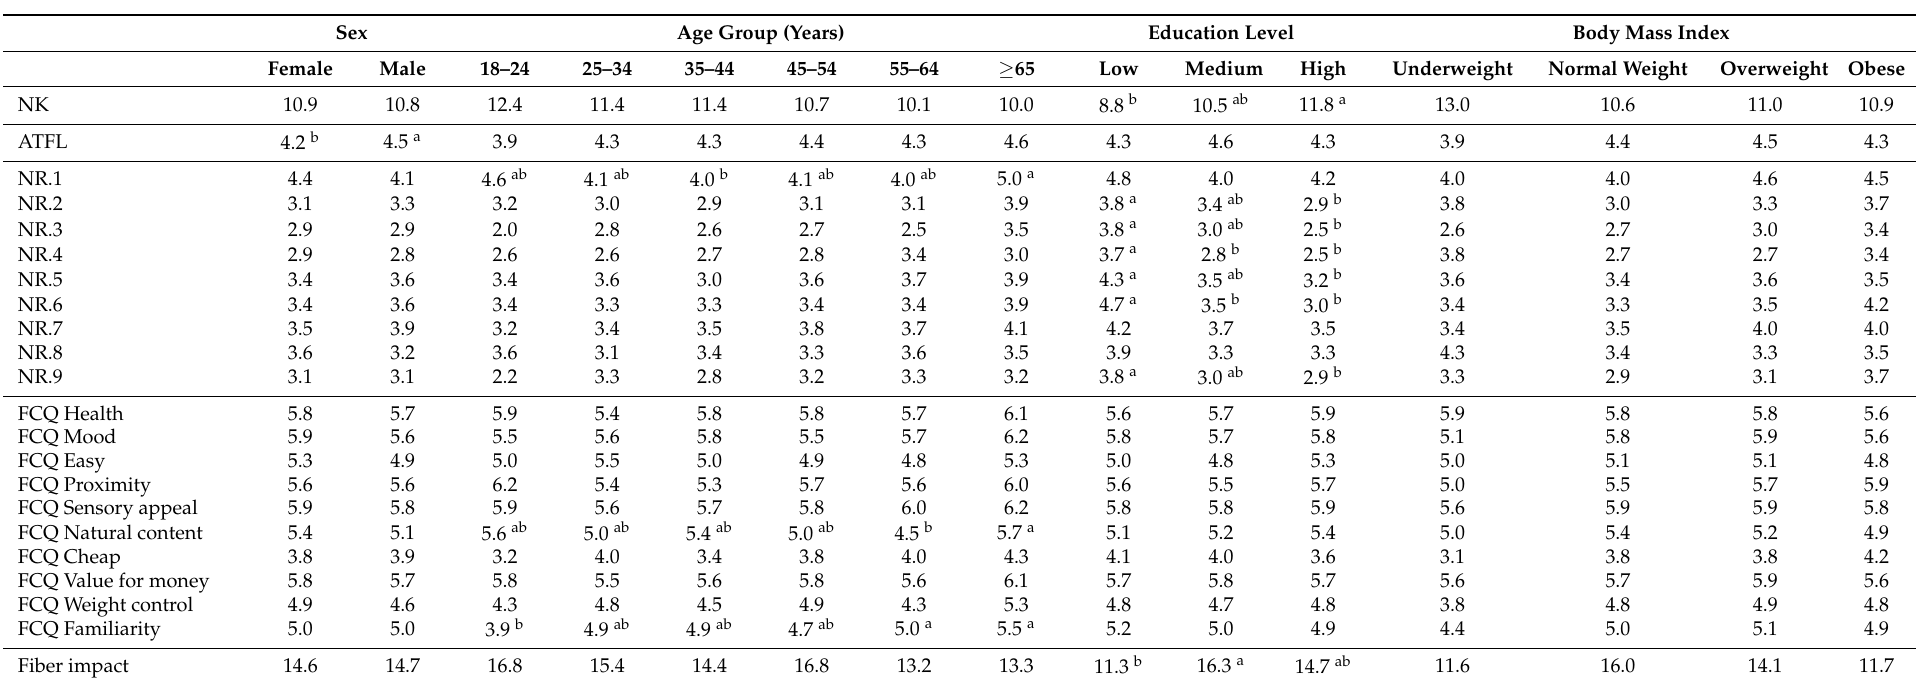
Table 4. Mean values for each item or construct of the questionnaire, sociodemographic level, BMI, and label reading percentages for the participants who did